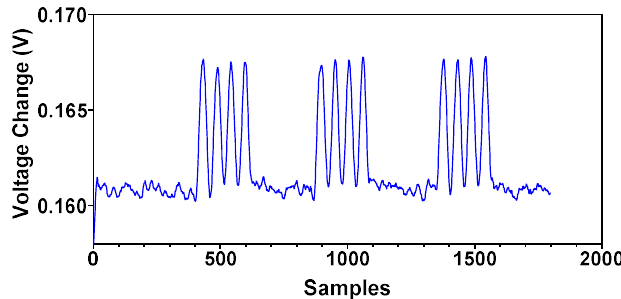
Figure 15. Dynamic response of the proposed magnetic tactile sensor for a force of 20 N at 4 Hz in the normal